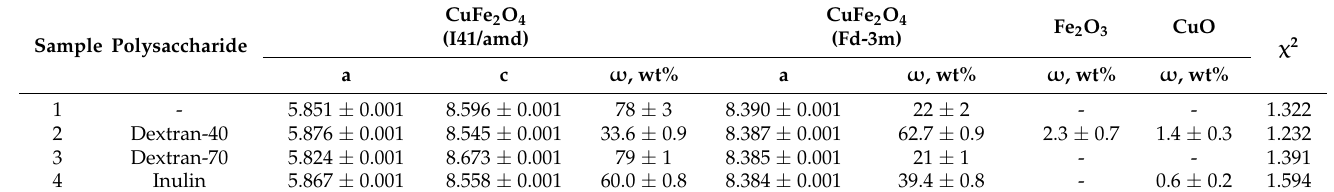
Table 3. Cell parameters and phase composition of the samples obtained by ion-exchange resin precipitation and annealed at 900 °C for 1 h.